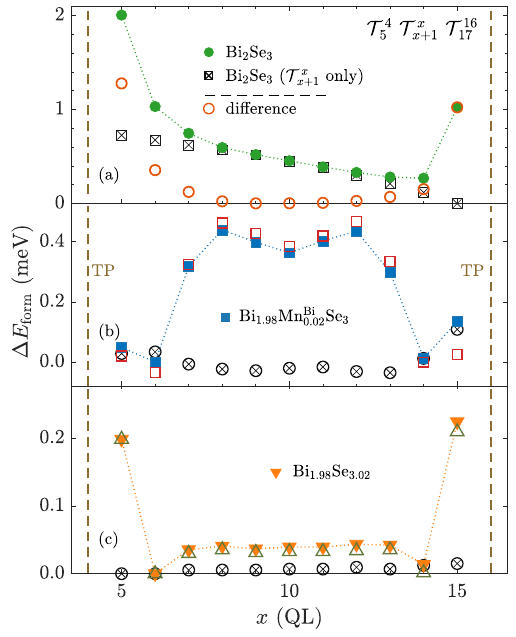
Figure 5. ( (cid:108) , (cid:4) , (cid:116) ) Relative formation energy of three TPs as a function of the position x of the middle TP. Positions of border TPs are fixed. The Bi 2 Se 3 multilayer consists of 20 QLs. ( a ) pure system without any disorder. ( b ) system with homogeneous magnetic doping. ( c ) system under presence of homogeneously distributed nonmagnetic disorder. ( ⊗ , (cid:2) ) Relative formation energy related to a single TP depicted for comparison. ( (cid:13) , (cid:3) , (cid:52) ) Energy curves associated to three TPs with a subtracted single TP curve contribution. Particular relative formation energy curves are related to different absolute